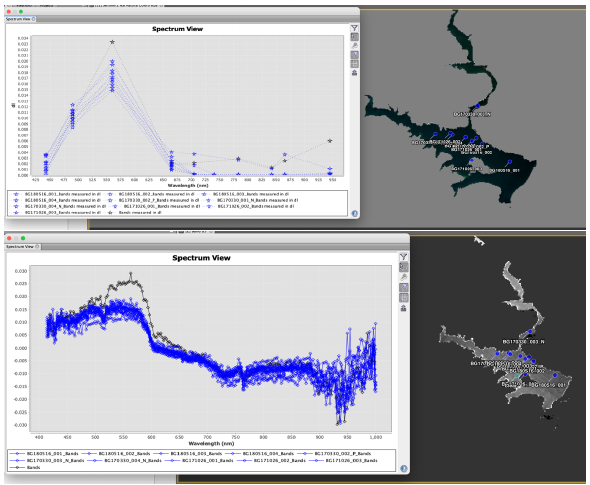
Figure 3. S2-MSI (top) ans DESIS (bottom) spectral signatures, Benageber reservoir